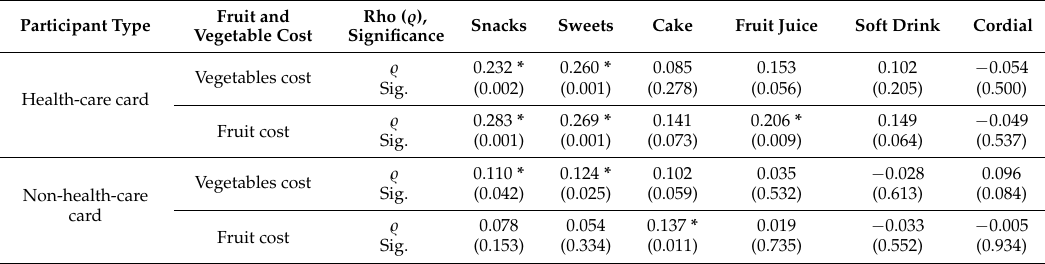
Table 3. Correlation between fruit and vegetables costing too much and other